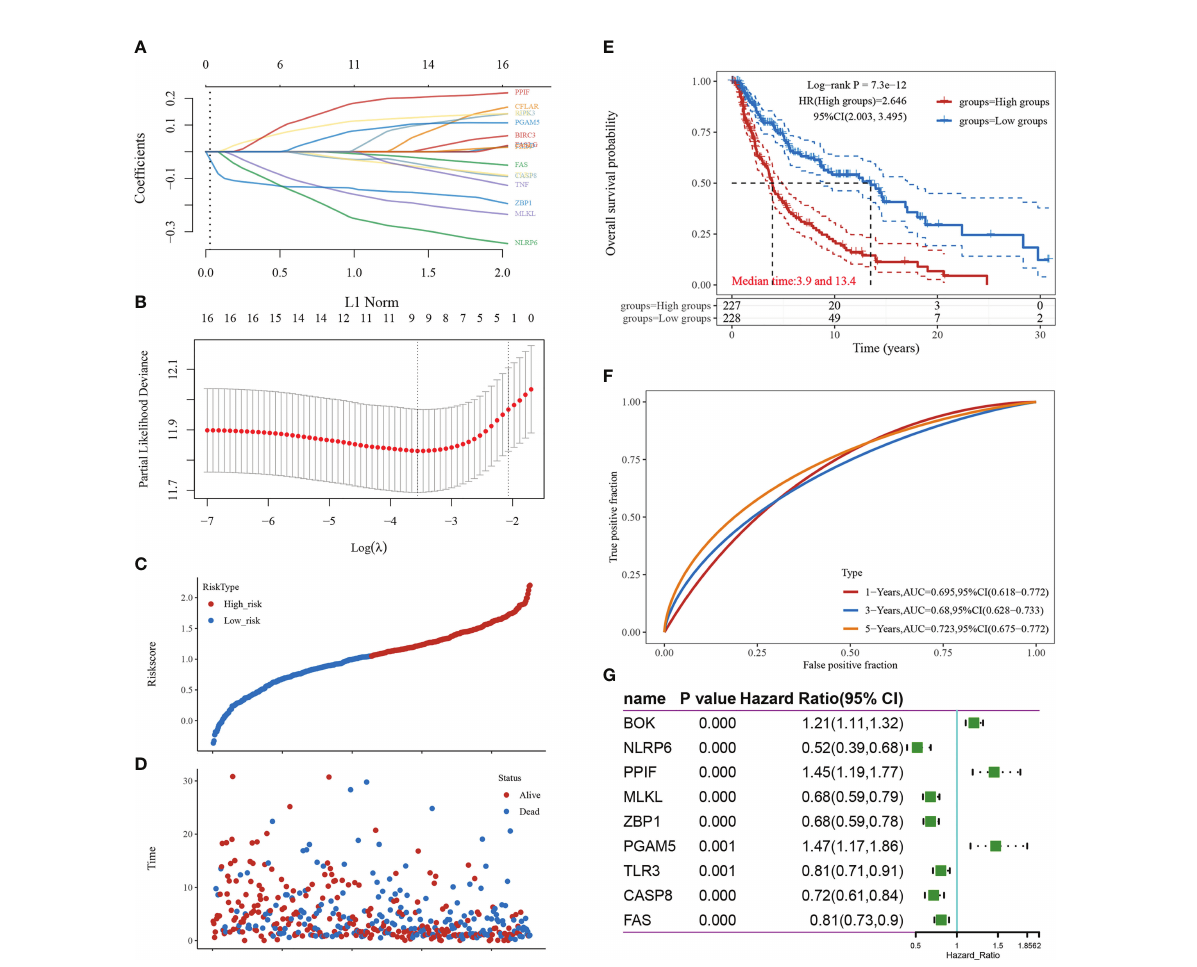
FIGURE 3 Screening of pivotal genes. (A) The coef fi cients for the selected features are presented as the l parameter. (B) Partial likelihood deviation plotted against log( l ) using the LASSO-Cox regression model. (C) Scatter plot of risk scores from low to high. (D) Scatter plot distribution of survival time and survival status corresponding to the risk scores of different samples. (E) KM survival curve plot based on the high and low grouping of risk scores, excluding some of the missing values containing samples with missing values. (F) ROC curve. (G) Forest plot showing the P-value, HR, and 95% CI of each